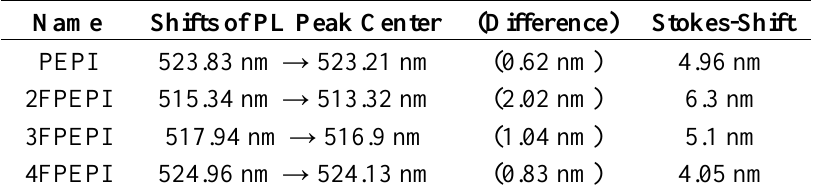
Table 2. PL peak shifts before and after long-time illumination of UV laser and Stokes-shift